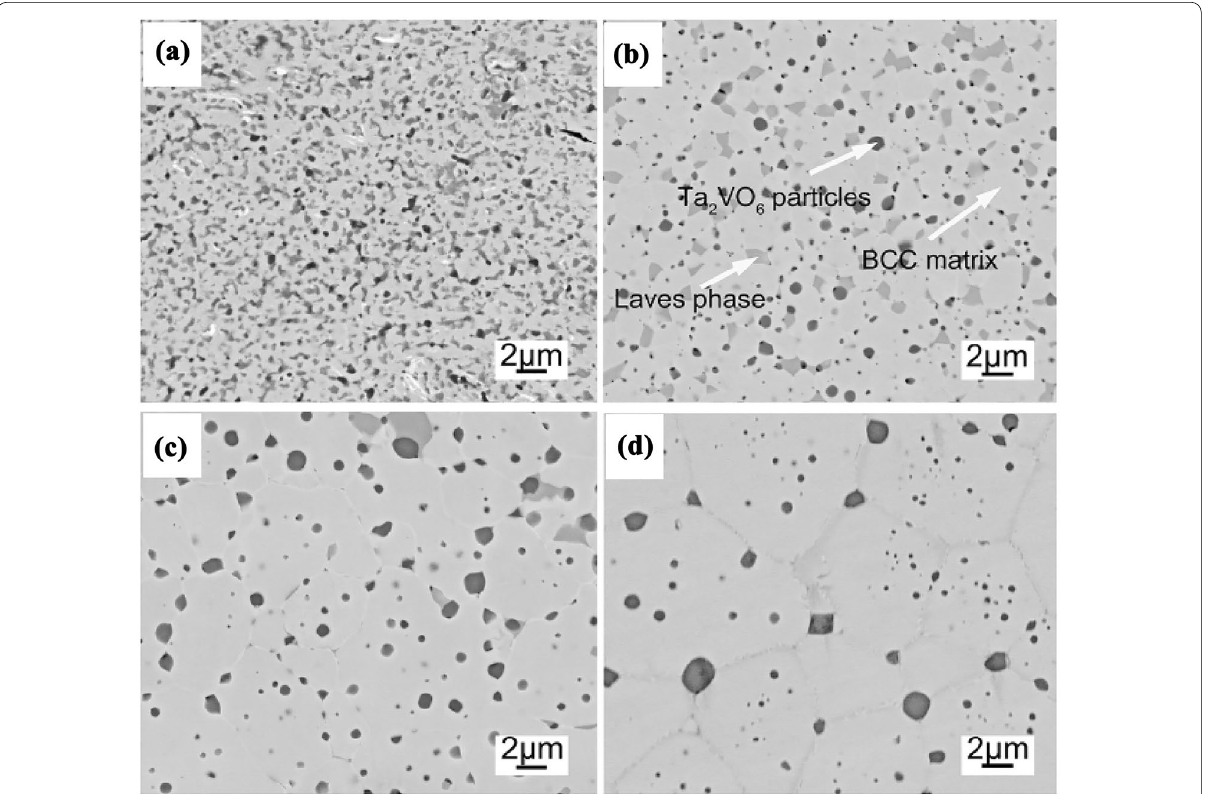
Figure 5 SEM backscattered electron images of the bulk NbMoTaWVCr HEA alloys sintered at different temperatures: ( a ) 1400, ( b ) 1500, ( c ) 1600 and ( d ) 1700 [37]